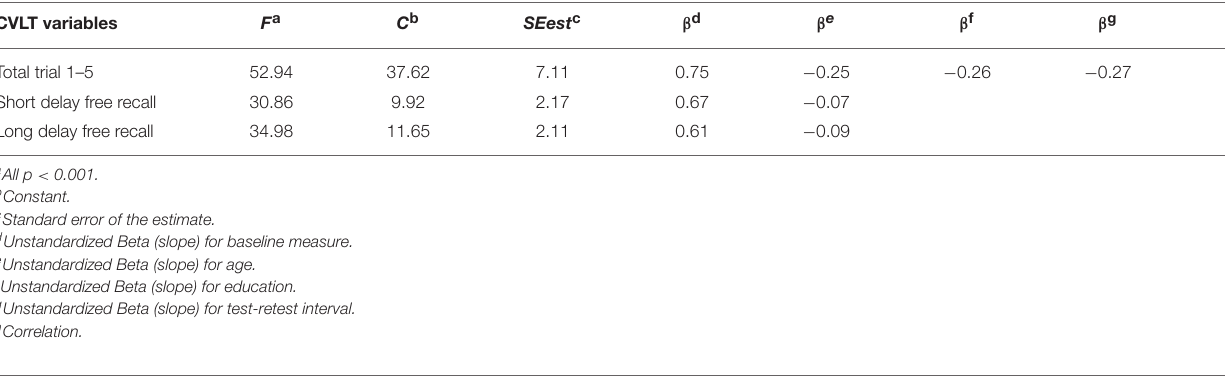
TABLE 4 | Comparison of the meaningful change for the multiple domain amnestic mild cognitive impairment (mda-MCI), single domain amnestic mild cognitive impairment (sda-MCI), and group with subjective memory complaints but without cognitive impairment (SMC) in the three studied primary measures. CVLT